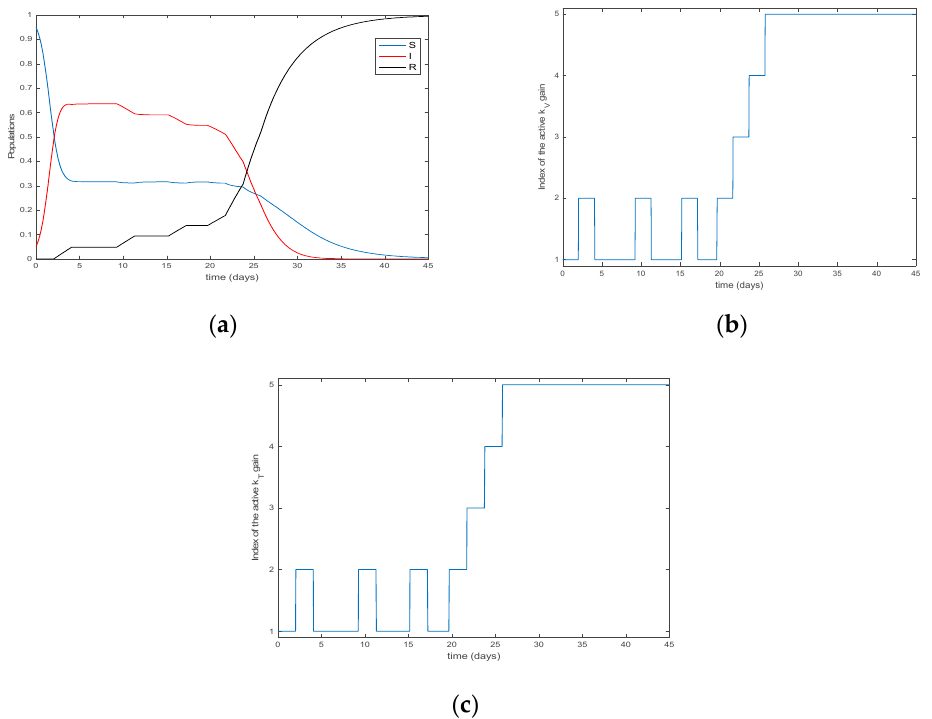
Figure 4. Performance of the system for β = 2.5 and γ = 0.79 days − 1 when vaccination and treatment are included in the model. The control parameters are S KV = S KT = {0 0.001 0.0035 0.0075 0.01}, T min = 2 days and λ = 0.5. The vaccination and treatment e ff orts are selected online via the variation of Algorithm 1 that only allows changes in steps of unity. ( a ) Evolution of model’s populations. ( b ) Index representing the active vaccination control gain versus time from S KV , parameterizing the vaccination e ff ort. ( c ) Index representing the active treatment control gain versus time from S KT , parameterizing the vaccination effort.